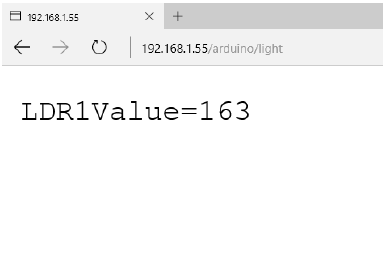
Figure 3. Web Page Showing the Light Value (Arduino